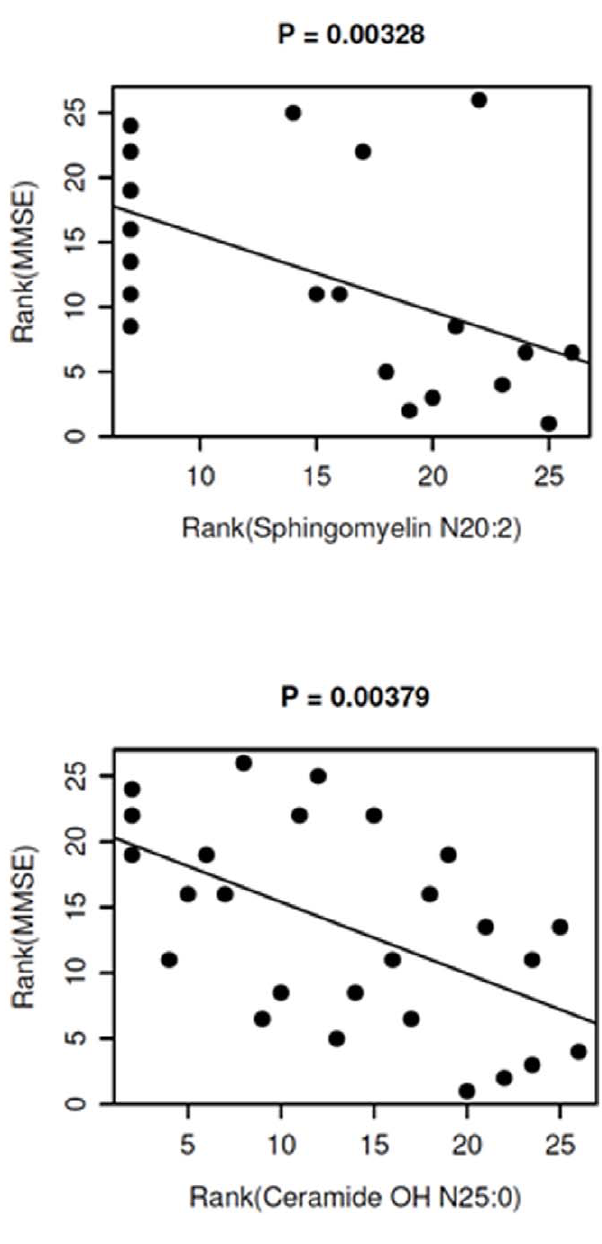
Figure 7. Correlation of the rank of the changed mean mass levels of sphingomyelin and ceramide species with the rank of AD severity. P values are based on Pearson’s product moment correlation coefficient between the ranks as plotted. The lines represent linear regressions of the ranks of the MMSE scores against the ranks of the